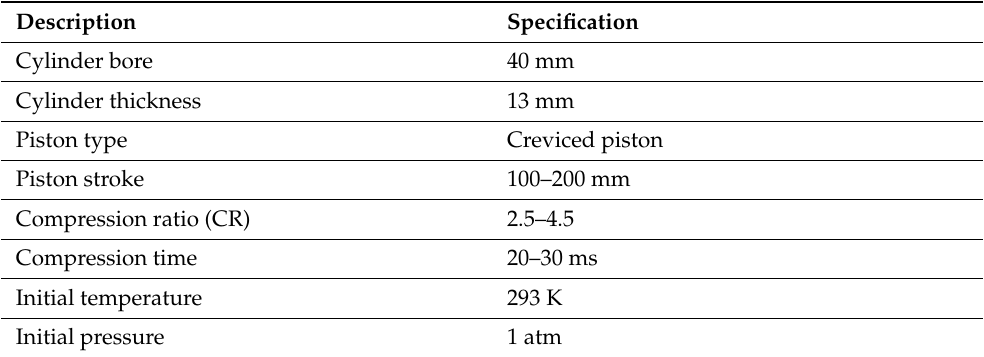
Table 1. Specification of the RCM